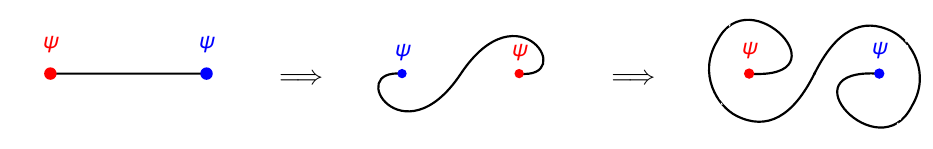
Figure 21 . Monodromy operation on a two-point function of the defect operator (cid:9) 2 H L : moving one (cid:9) around the